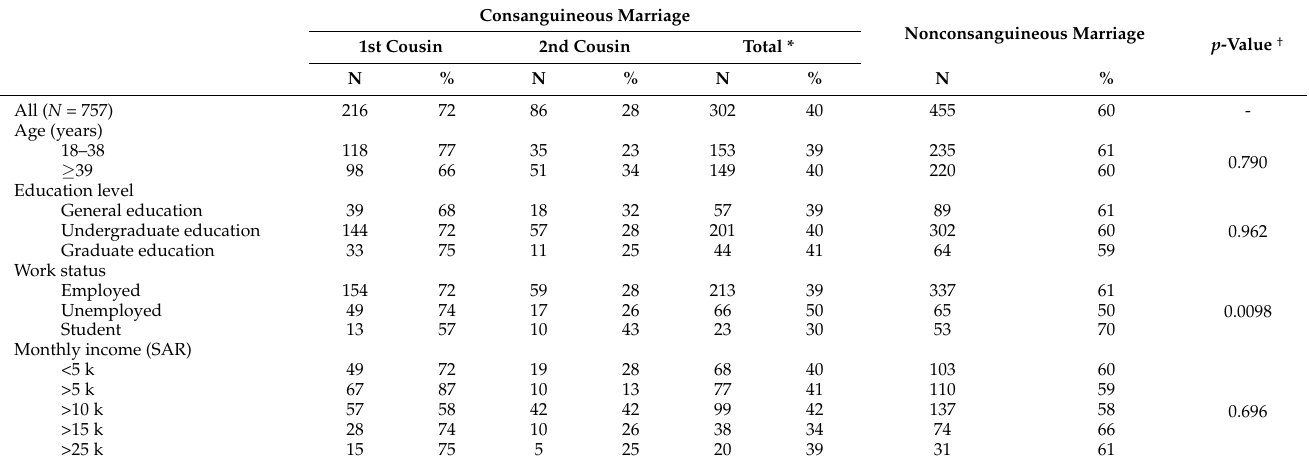
* Indicates the total number and the percentage of participants with a first- or second-cousin marriage. † p -values Int. J. Environ. Res. Public Health 2023 , 20 , x FOR PEER REVIEW were estimated using a chi-squared test for comparison between two groups of participants: those in a consan- guineous marriage and those in a nonconsanguineous marriage. SAR: Saudi Arabian riyals.